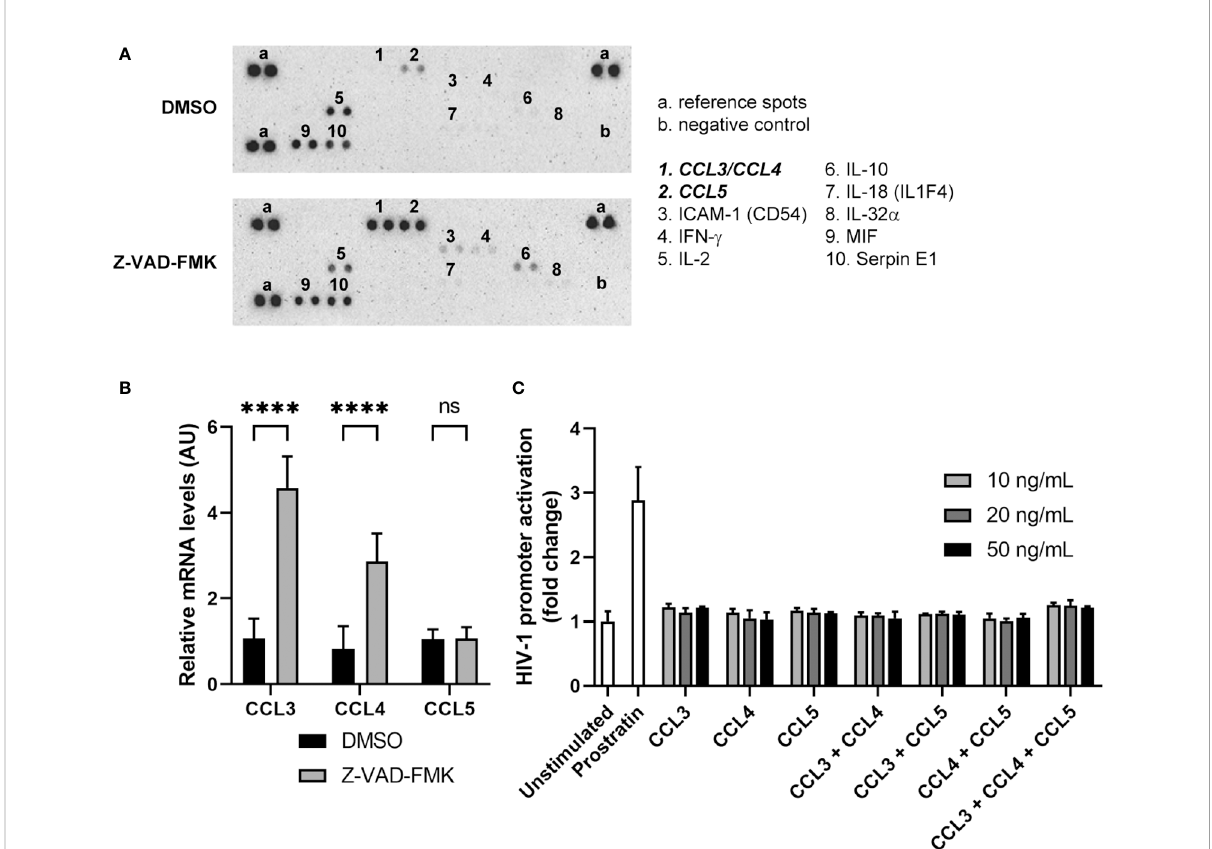
FIGURE 5 Pan-caspase inhibitor-treated NK cells secrete increased levels of HIV-1 suppressor cytokines. (A) KHYG-1 cells were incubated with Z-VAD- FMK or only DMSO. After 24 h, supernatants were collected and subjected to a cytokine array. (B) RNA from Z-VAD-FMK-treated or DMSO- treated (control) KHYG-1 cells was isolated and mRNA levels of CCL3, CCL4, CCL5, and GAPDH was measured by qPCR. GAPDH was used to normalize for input, and the average mRNA level for DMSO (n=6) was set to 1. (C) TZM-bl cells were incubated with various concentrations of CCL3, CCL4, CCL5, or combinations of these three chemokines (n=3). After 24 h, activation of the HIV-1 promoter was measured by luciferase assay. For all graphs, data points are plotted as mean ± SD. (ns, non-signi fi cant; ****p < 0.0001;